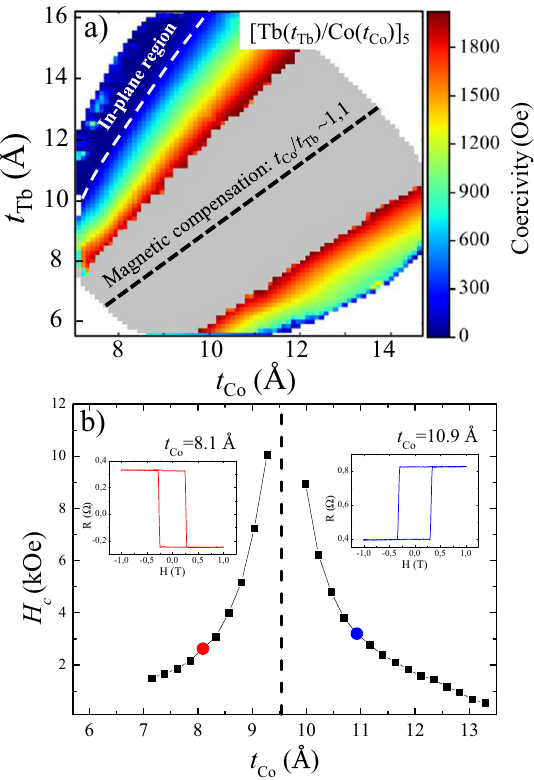
Figure 1. ( a ) Coercive field map of [Tb( t Tb )/Co( t Co )] 5 . The coercive field values were obtained from the M ( H ) loops measured with H applied perpendicular to the plane of the film. The superimposed gray region in the center indicates the region in which H was not sufficient to saturate the stack. The black dashed line schematically represents the thickness values of Tb and Co for which the coercive field diverges i.e. where magnetic compensation occurs at room temperature. ( b ) Coercive field of [Tb/Co] 5 multilayer as a function of Co thickness t Co : 7–13 Å with the thickness of the Tb layers fixed at t Tb = 10 Å . Insets: R ( H ) for t Co = 8.1 Å and t Co = 10.9 Å as indicated.